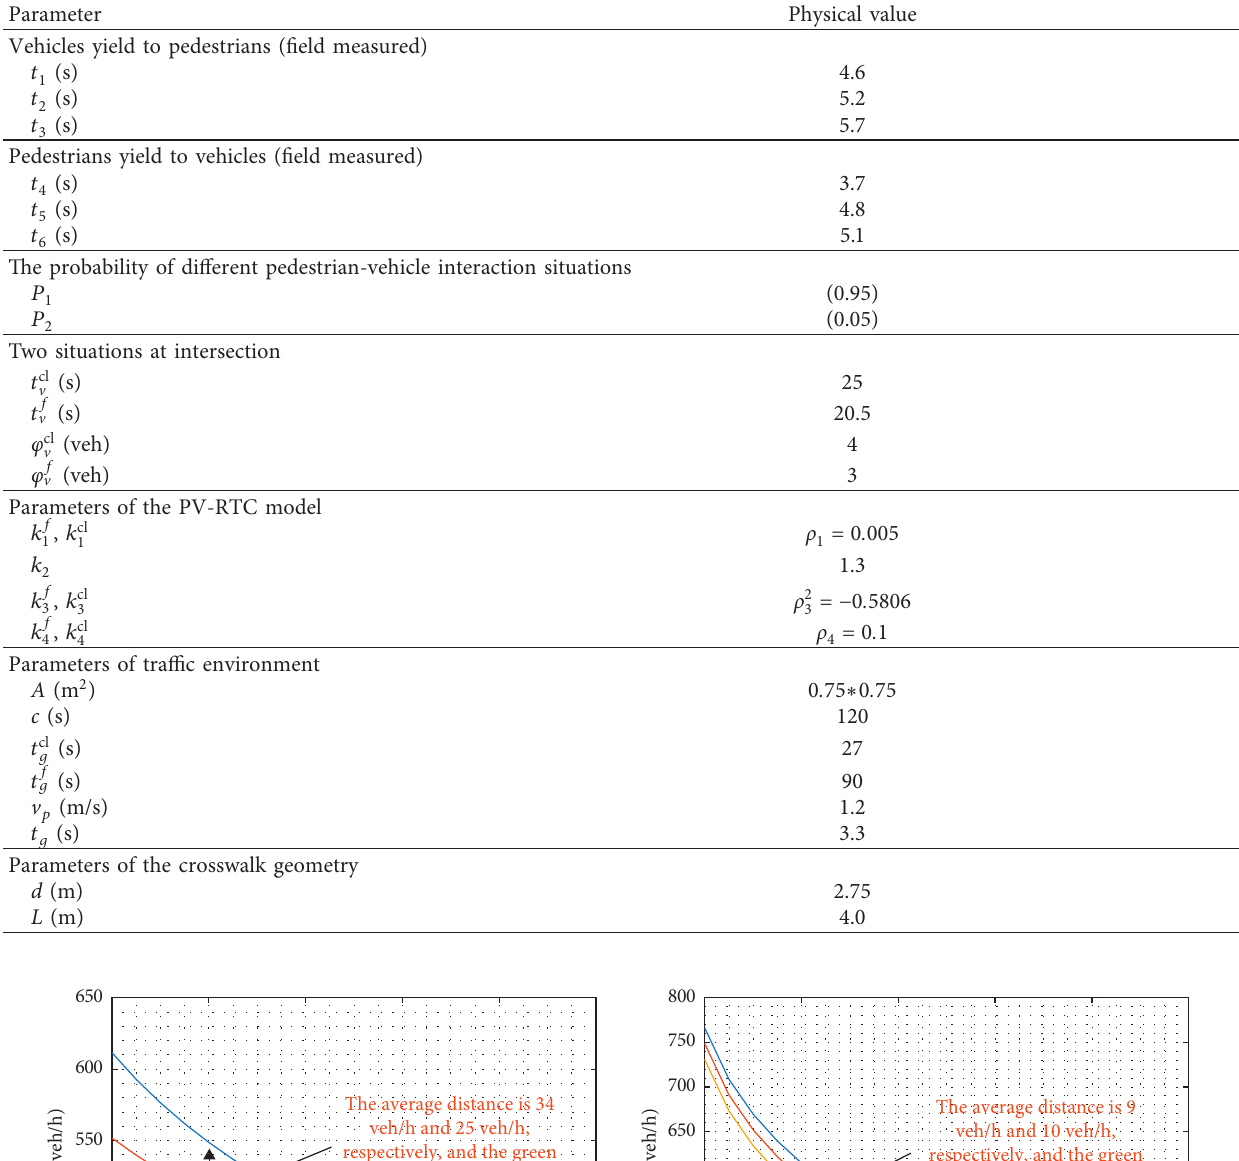
Table 6: Parameters in sensitivity